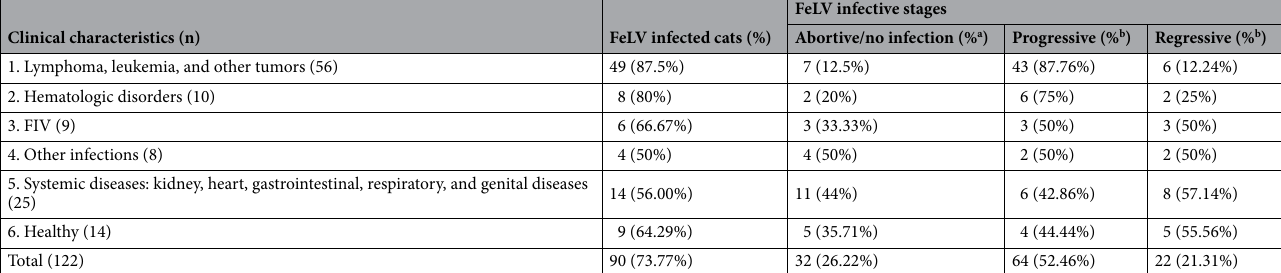
Table 5. Clinical characteristics and FeLV infective stages. a % from each clinical characteristic. b % from FeLV infection in each clinical